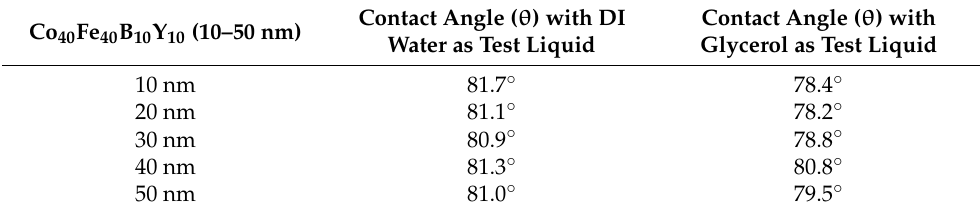
Table 3. Average contact angles of CoFeBY nanofilms at RT with DI water and